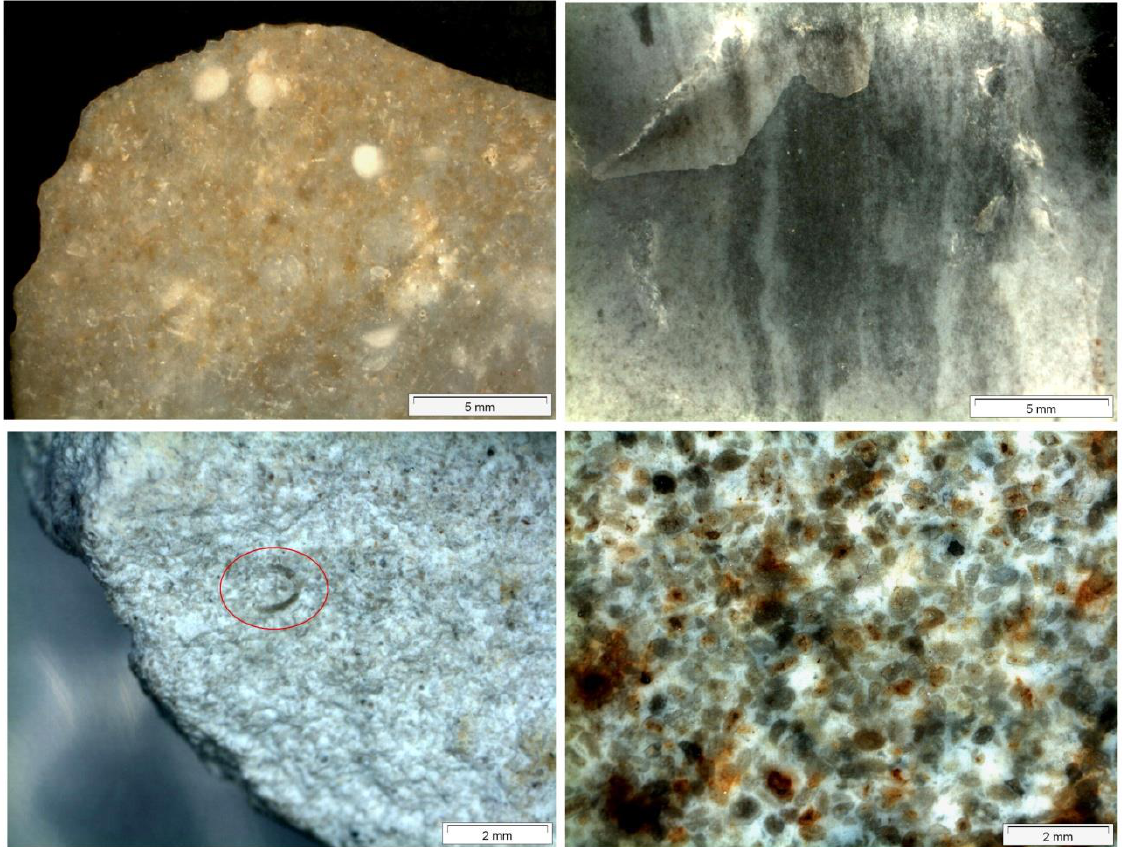
Figure5. Different textures and varieties of chert from Charente's basin. From left to right and up to down: sample 44-1 from lower Cenomanian (F1 variety), sample 63 from middle Cenomanian (F3 variety), sample 45 from middle Turonian (E2 variety) and sample 20-6 from upper Turonian (E6d